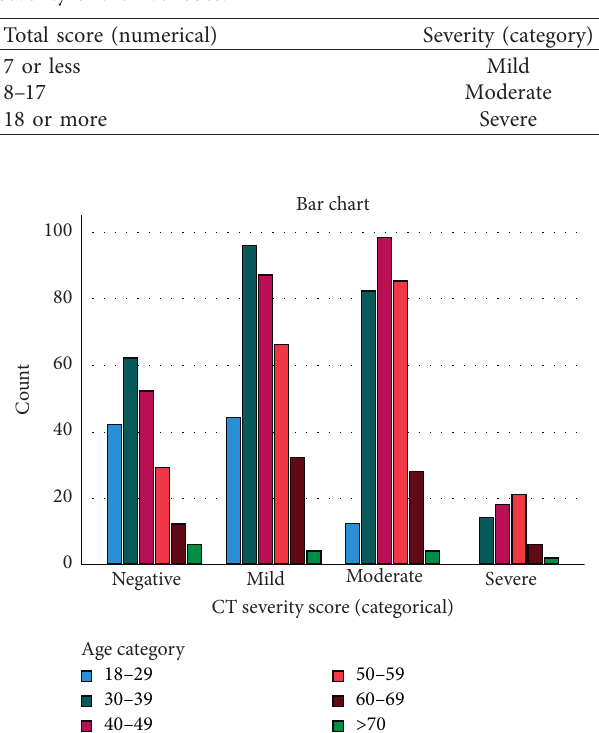
Table 2: Sum of the individual lobar scores indicates the overall severity of the five lobes.